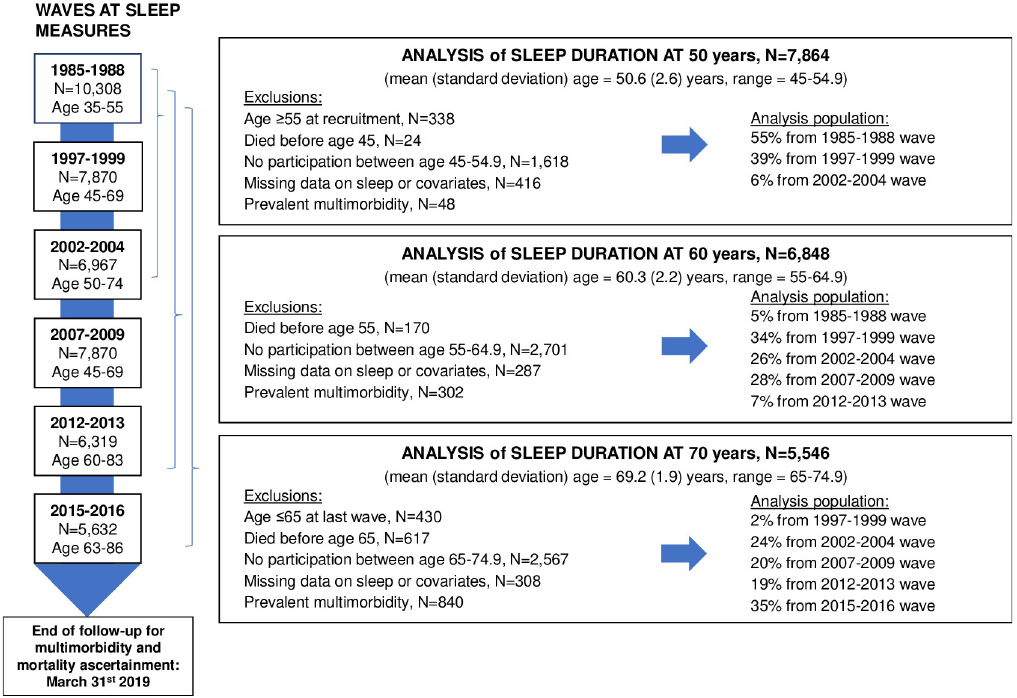
Fig 2. Flowchart for analyses on the association between sleep duration at age 50, 60, and 70 and risk of multimorbidity.